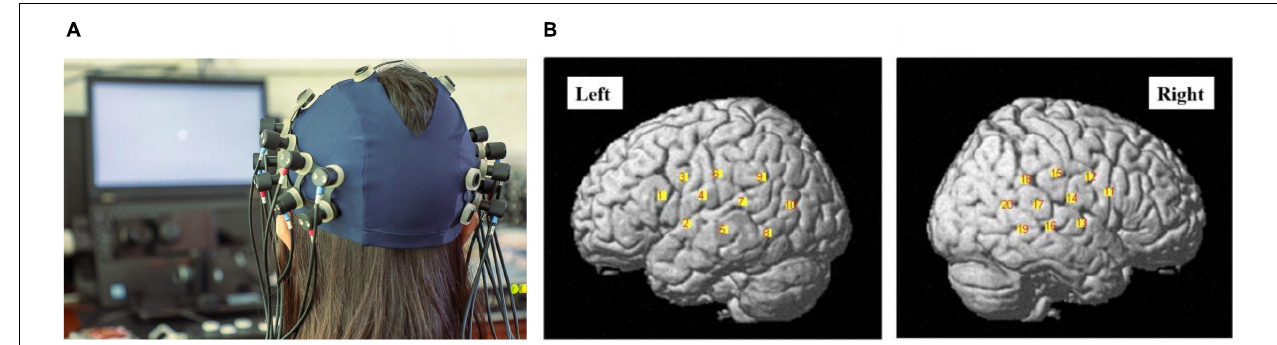
FIGURE 3 | (A) The photograph of the optode array placed on the head of one of the participants (with consent). Red and blue labels on the optodes indicate optical sources and detectors, respectively. (B) The channel positions following registration to a brain atlas with different numbers (channels 1–10 left-hemisphere, channels 11–20